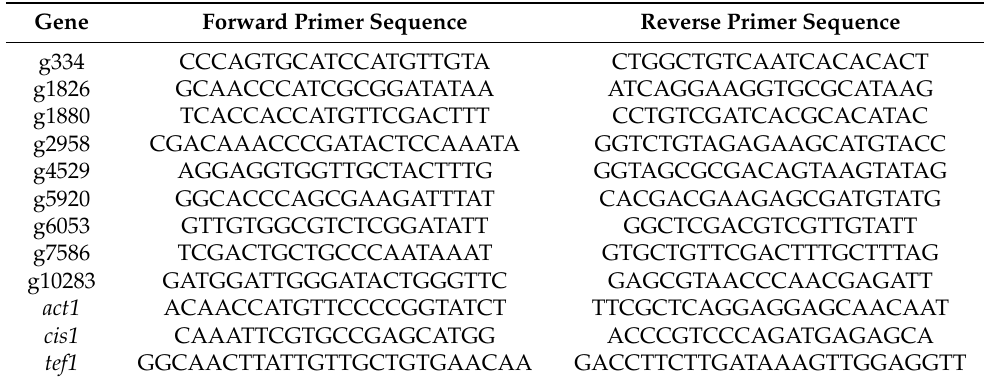
Table 1. Oligonucleotide primers used in this